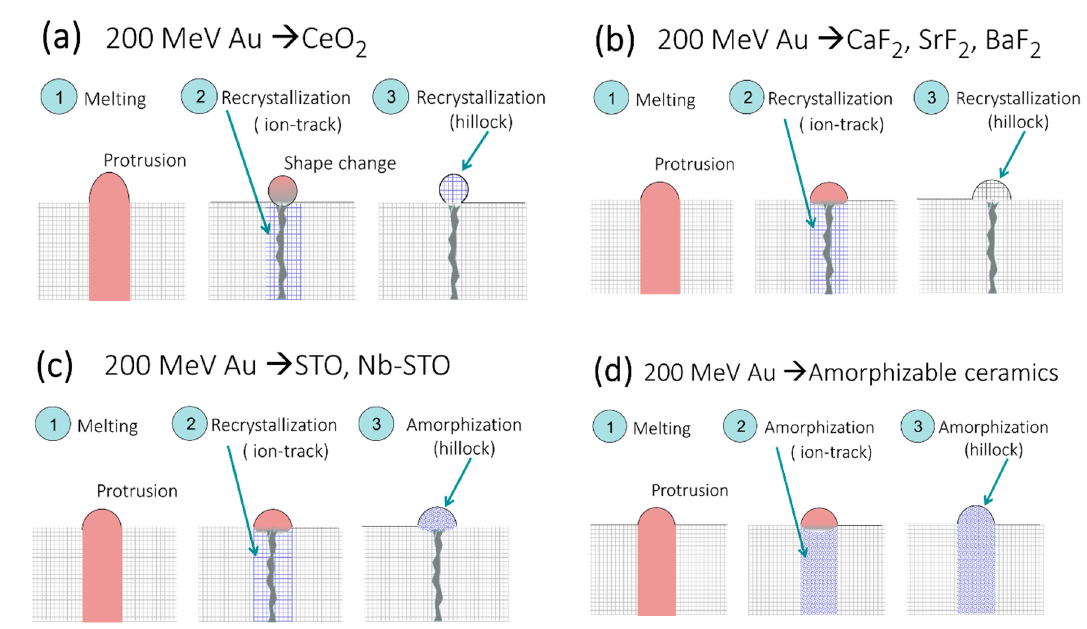
Figure 8. Schematic formation processes of ion tracks and hillocks in ( a ) CeO 2 , ( b ) fluorides (CaF 2 , SrF 2 , and BaF 2 ), ( c ) STO and Nb-STO, and ( d ) amorphizable ceramics (YIG, LiNbO 3 , ZrSiO 4 , and GGG).